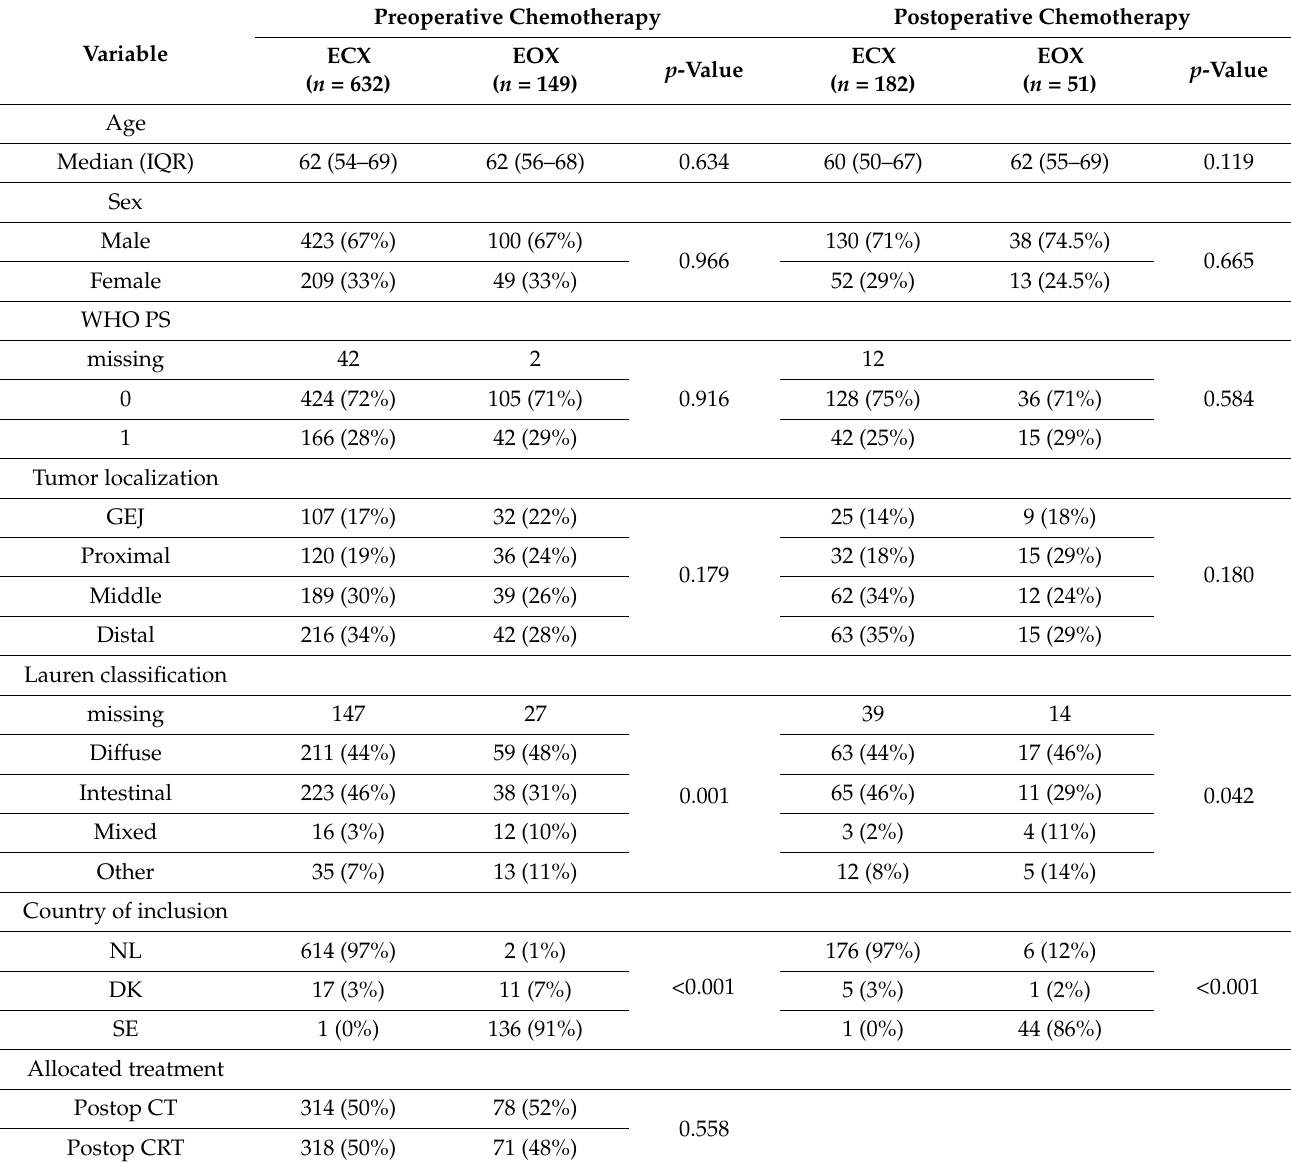
Table 1. Baseline characteristics for patients who started preoperative chemotherapy and for pa- tients who started postoperative chemotherapy, respectively. Abbreviations: The Netherlands (NL), Denmark (DK), Sweden